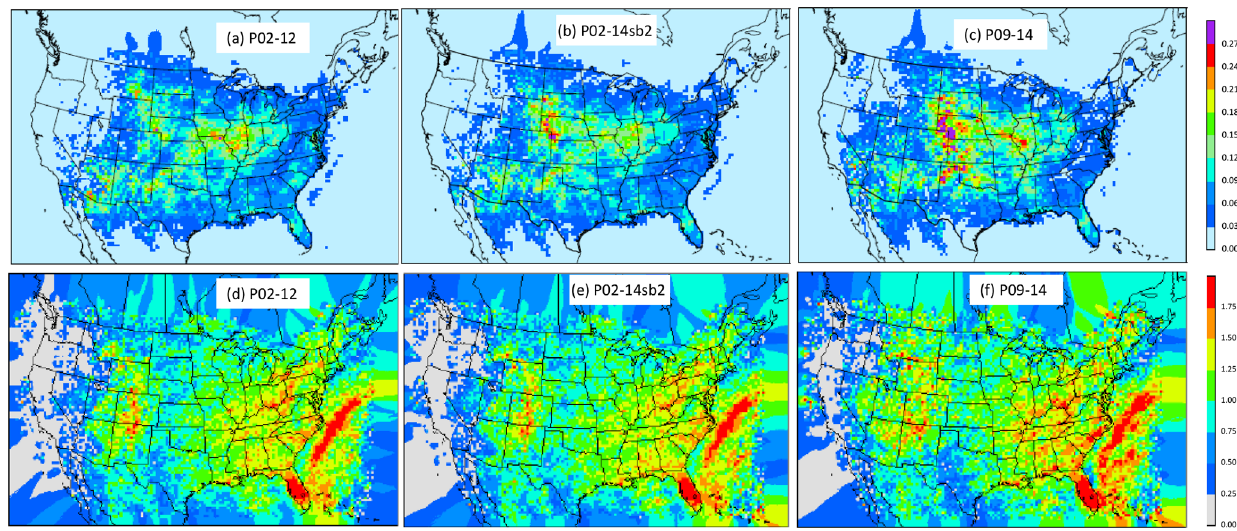
Figure 6. The slope maps from linear (a–c) and log-linear (d–f) regressions using data from different time periods. (a, d) Data from 2002 to 2012, (b, e) data from 2002 to 2014 excluding 2011 and 2013, and (c, f) data from 2009 to